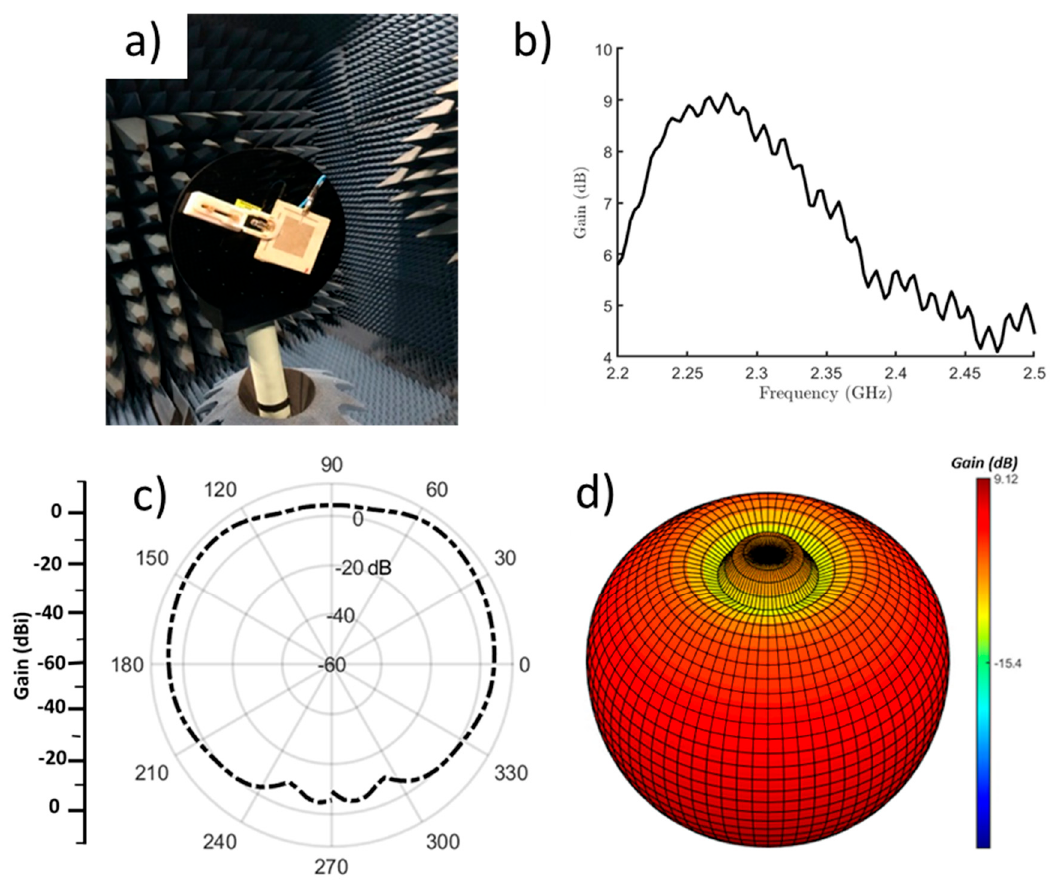
Figure 7. ( a ) Experimental setup for the textile antenna with the combination substrate (two layers of nonwoven fabric and six layers of knit fabric spray coated with BT dielectric ink) for 3D radiation pattern measurements in an anechoic chamber. ( b ) Maximum gain plot at φ = 0°. ( c ) Two-dimensional radiation pattern of the textile antenna at 2.3 GHz and φ = 0°. ( d ) Three-dimensional radiation pattern of the textile antenna plotted in dB at 2.3 GHz.